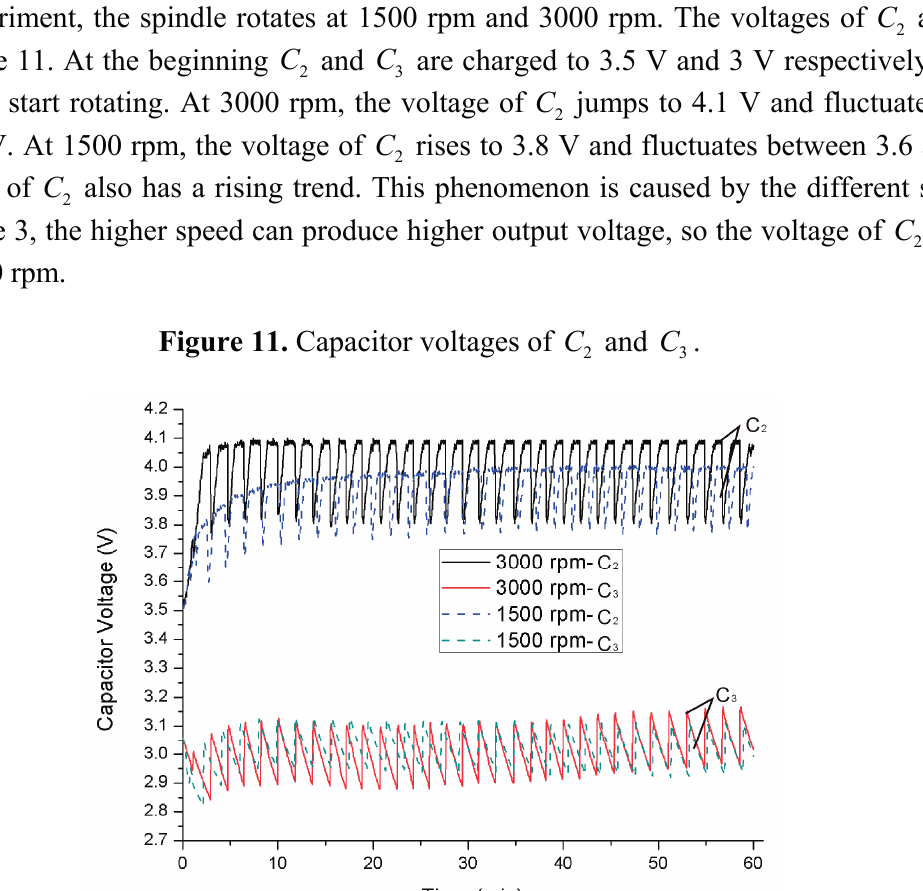
Figure 11. Capacitor voltages of